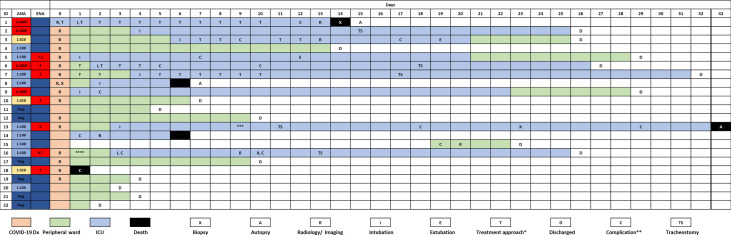
Timeline of the complete study cohort. *, treatment modalities are summarized in
Supplementary Table 1
; **, case-related complications are summarized in
Supplementary Table 5
; ***, patient was transferred to another institution because vv-ECMO was required; ****, patient w/chronic lymphocytic leukemia (CLL) and antibody deficiency syndrome. Rheumatoid factor was positive in this case. 1–7Specific ENAs: 1anti-SS-B, 2anti-PM-Scl, 3anti-Jo, 4anti-CENP, 5anti-Scl-70, 6anti-Nucleosome, 7anti-dsDNA.